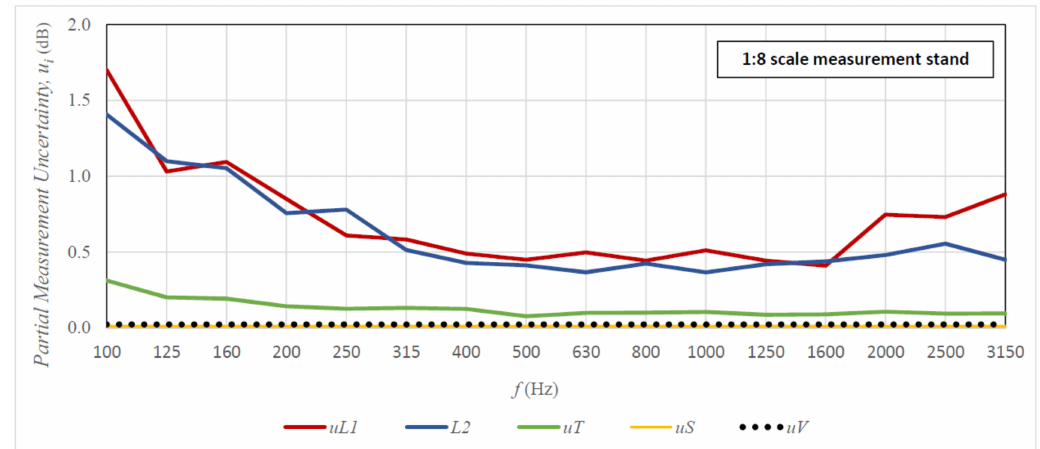
Figure 10. Share of measurement uncertainty of variables L 1 , L 2 , T , S , and V in the total uncertainty of sound insulation measurement of the 125 × 250 mm m plexiglass specimen; measurements on the 1:8 scale stand for the 10-element measurement sample. The results from the scaled rooms were scaled to actual measurement